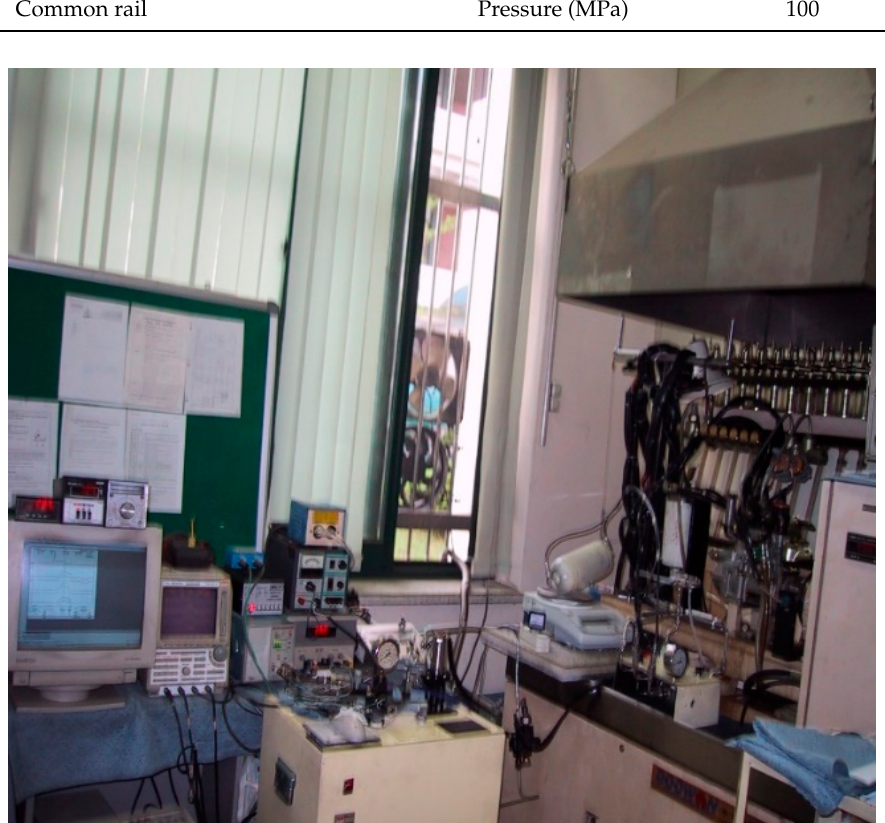
Figure 2. Photograph of the experimental rig.